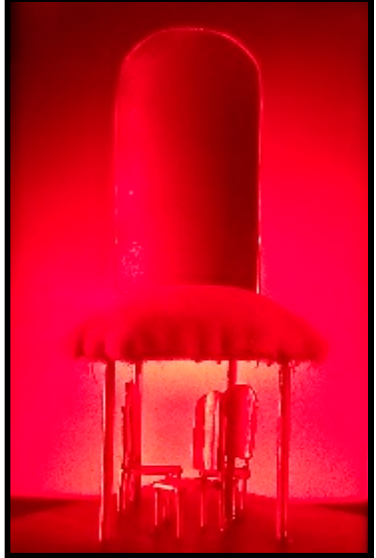
Figure 3. Louise Bourgeois, one of Series of Eight Holograms , 1998–2015 (photo taken by the author). The Bourgeois holograms technically could have been illuminated with a white point source of light but an informed decision was made to use a monochrome source for depth and clarity necessary to reconstruct the many visual elements in the images and to suggest a reference 2 back to the red laser used to create the holograms. If these holograms are displayed in other venues without the